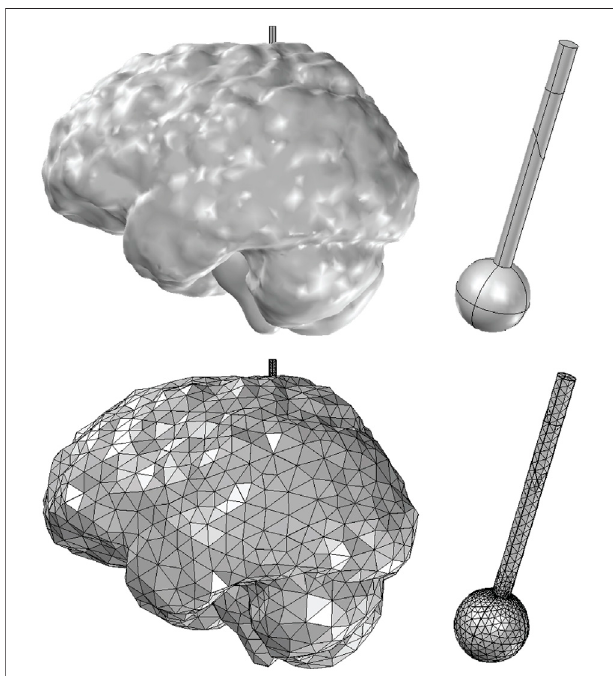
FIGURE 1 | Three-dimensional domain and FE model employed for simulating convection-enhanced delivery of drugs to brain tumors. The models consist of the white and gray matter of the brain reconstructed from MR images of a healthy adult, a tumor of spherical shape (6 mm radius) and the catheter (1.5 mm radius). The entire model consists of 88,530